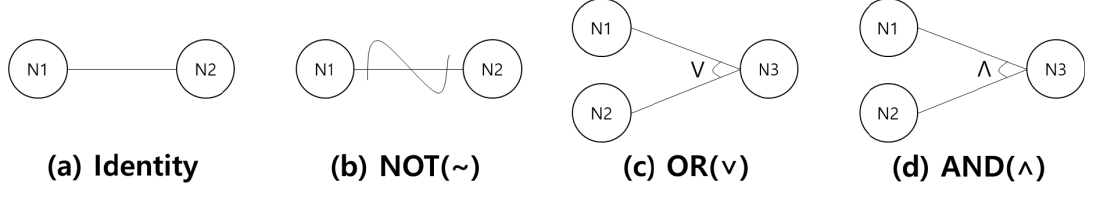
Figure 1. Connection Types between the identified Nodes for the Cause-Effect Graph.